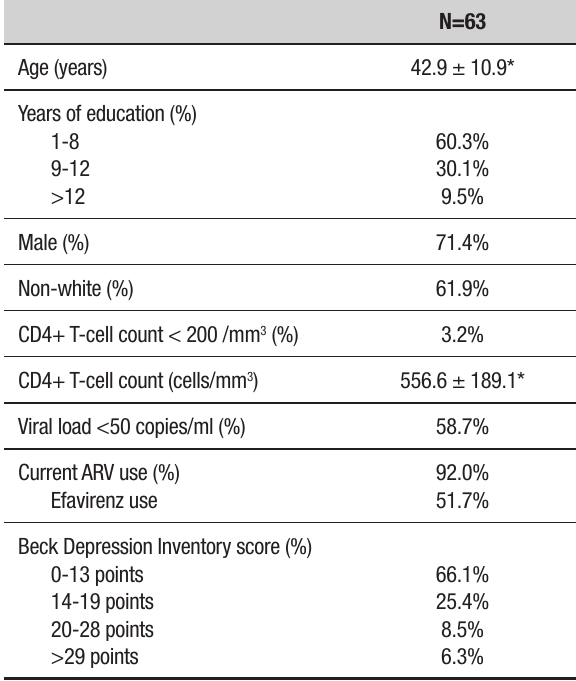
Table 1. Baseline demographic and clinical characteristics of all patients included.